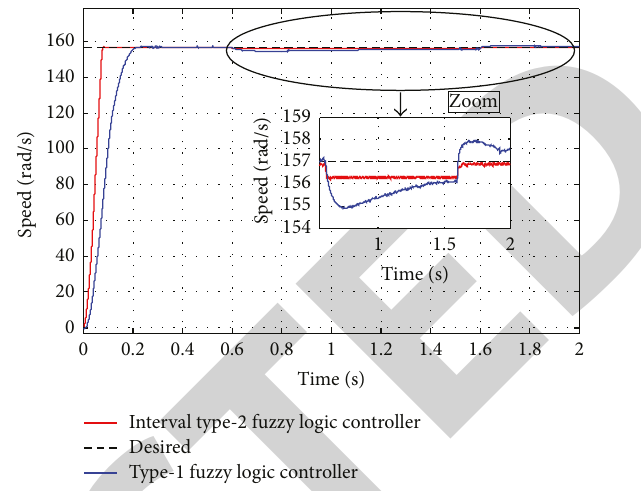
Figure 11: Simulated results comparison of IT2FLC and T1FLC of speed control of DFIM under load variation with zoom in the interval [0.6Sec–2 Sec] under a load Cr = 5N ⋅ m. Table 3: Performance error indexes